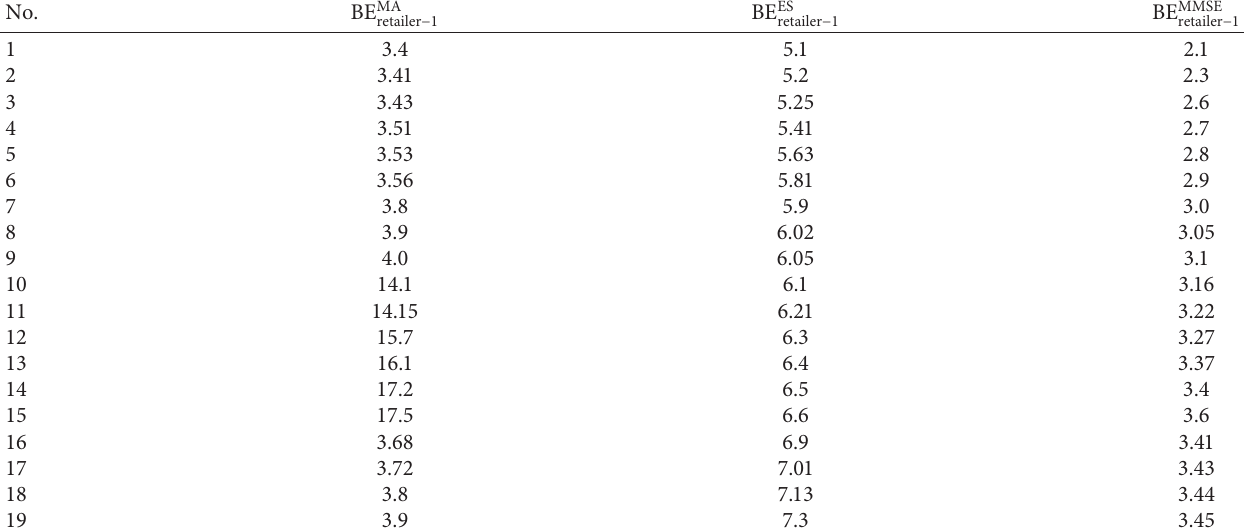
Table 4: The simulation